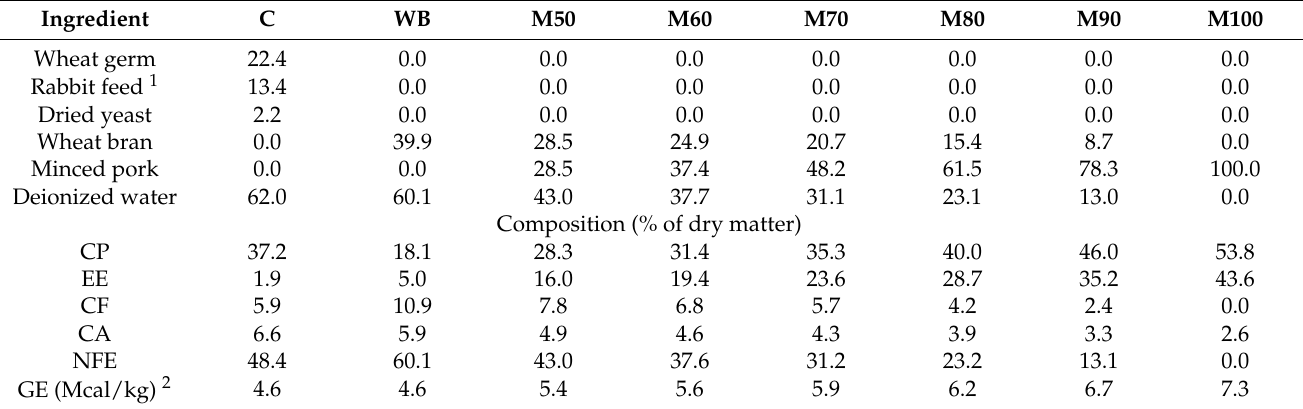
Table 2. Ingredients and proximate composition of diets in Experiment 2.